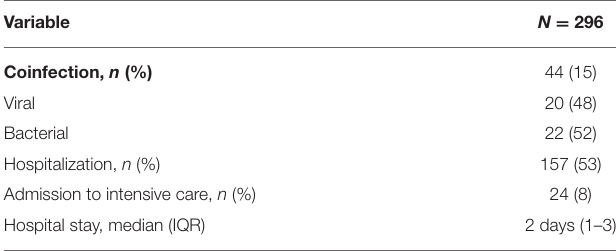
TABLE 2 | Characteristics of patients with COVID-19 symptoms.